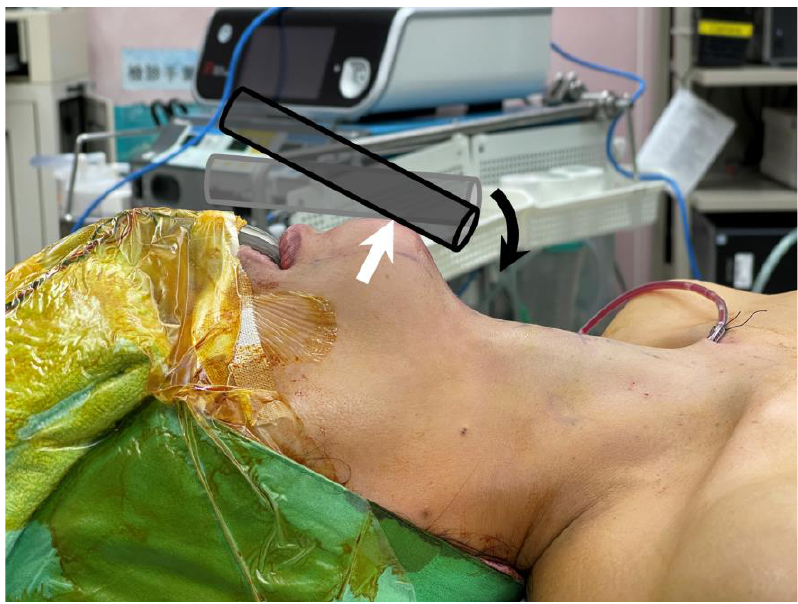
Figure 4. Proposed mechanism for cannula fracture. During the surgery, the observation port ( black cylinder ) is tilted down ( black arrow ) to inspect the operative field. This action applies a force against the mandible, which results in an equal counterforce ( white arrow ) to the cannula that leads to cannula breakage.